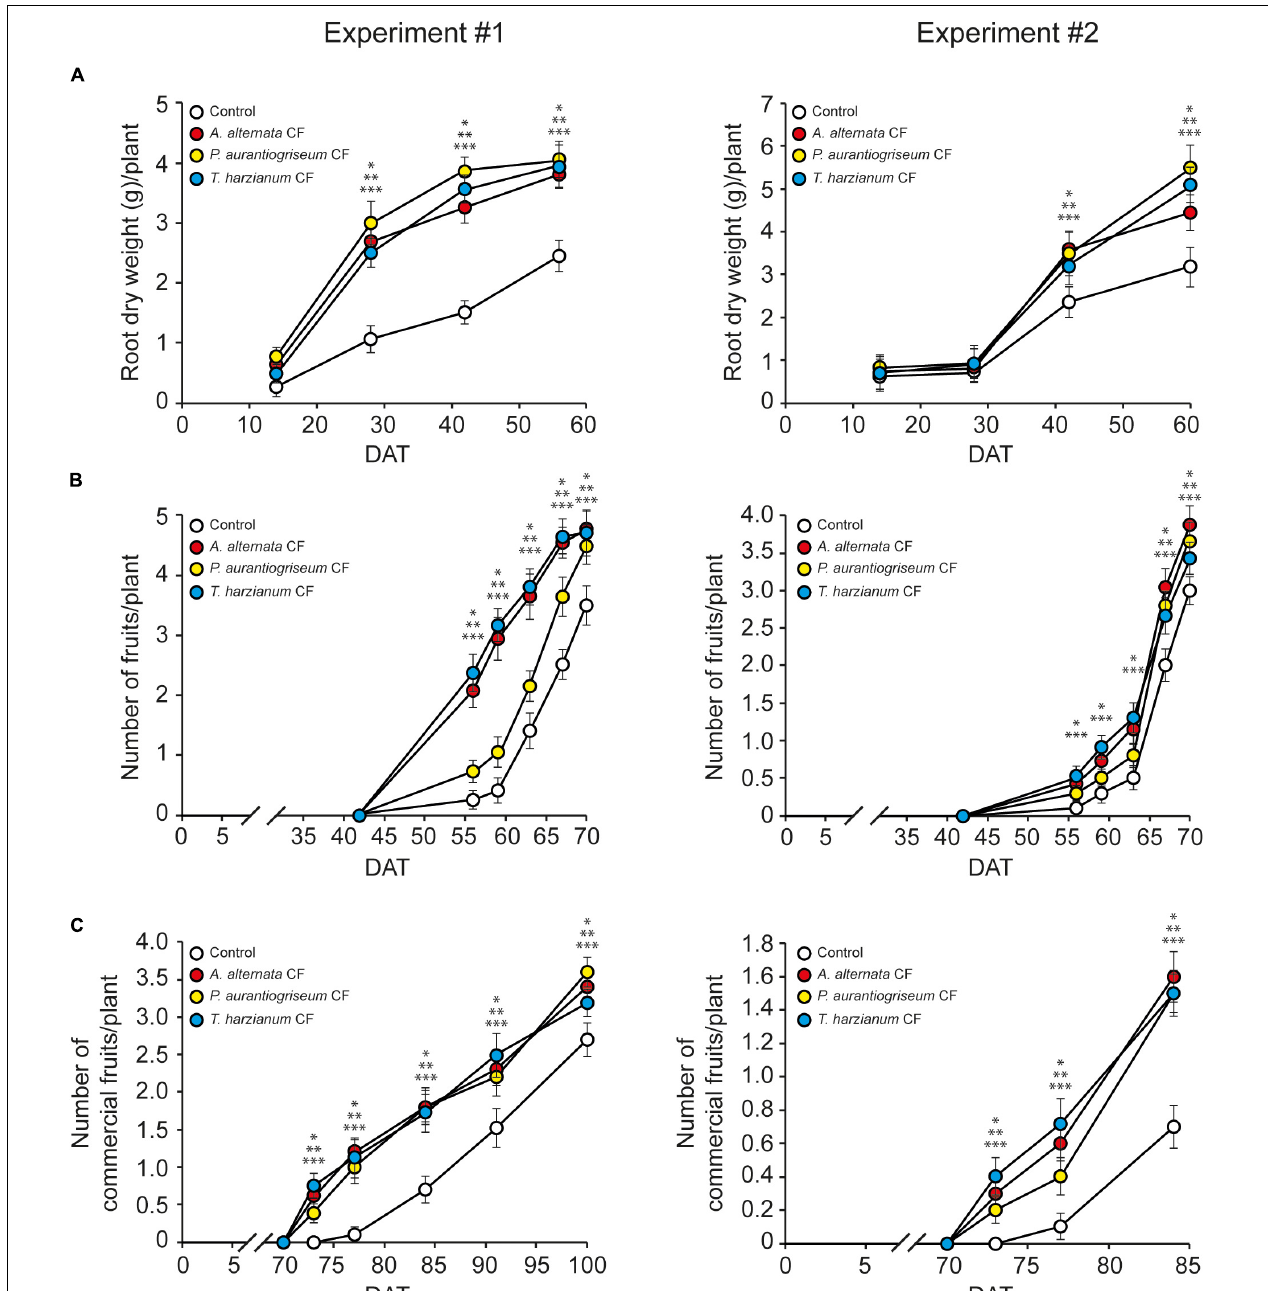
FIGURE 1 | Soil application of fungal CFs stimulates root growth and induces early fruit development in pepper plants. Data over the time for root dry weight (A) and number of total fruits (B) and commercial fruits (C) per pepper plant (cv. Sweet Italian) after the first soil application of A. alternata, P. aurantiogriseum , and T. harzianum CFs. Plants were grown under greenhouse conditions. Values were obtained from two independent experiments and represent the mean ± SD of 12 different plants. Asterisks indicate significant differences between CF-treated plants and plants irrigated with CF control according to a Student’s t -test (* P < 0.05, + A. alternata CF; ** P < 0.05, + P. aurantiogriseum CF; *** P < 0.05, + T. harzianum CF). DAT, Days after